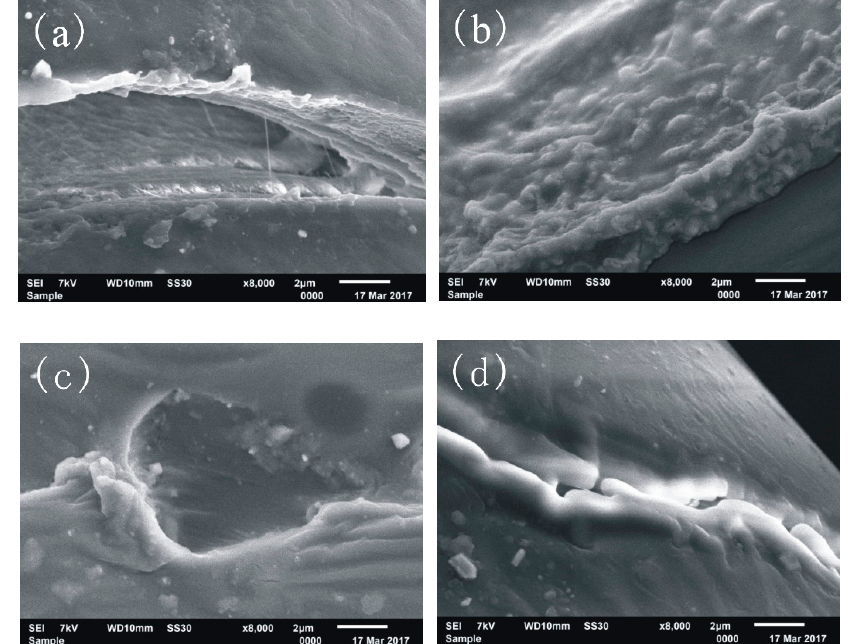
Figure 6. Four structure defects of sutures: ( a ) peeling, ( b ) swelling, ( c ) corrosion hole, ( d ) ditch.